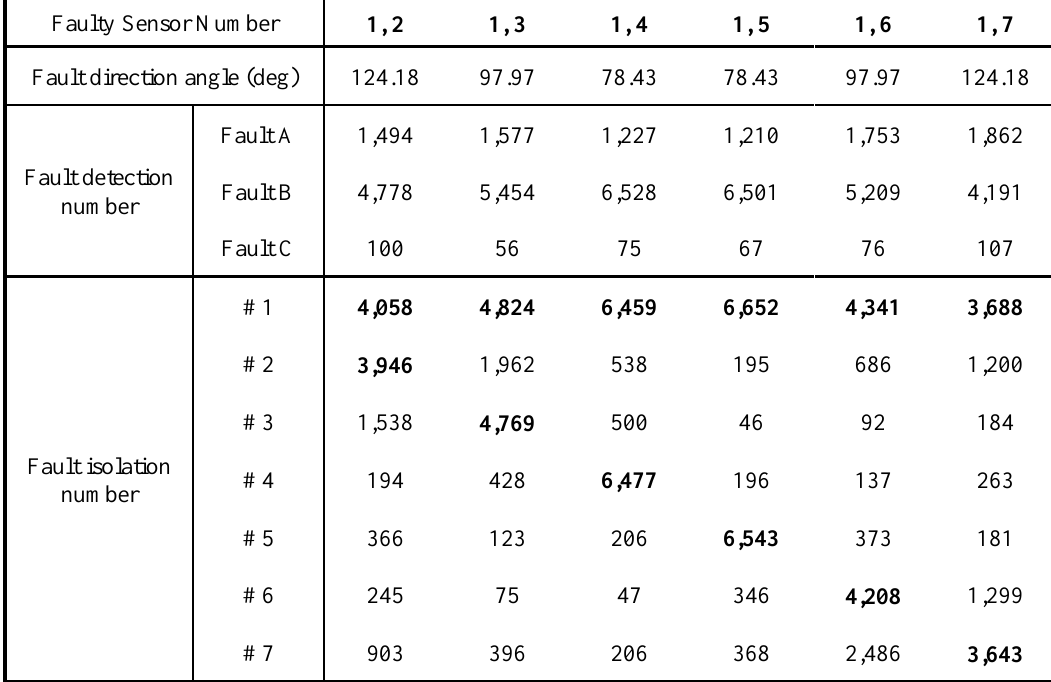
Table 3. Conventional EPSA FDI